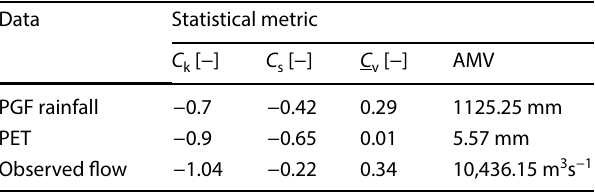
Table 2 Statistical metrics in PGF rainfall, PET and observed